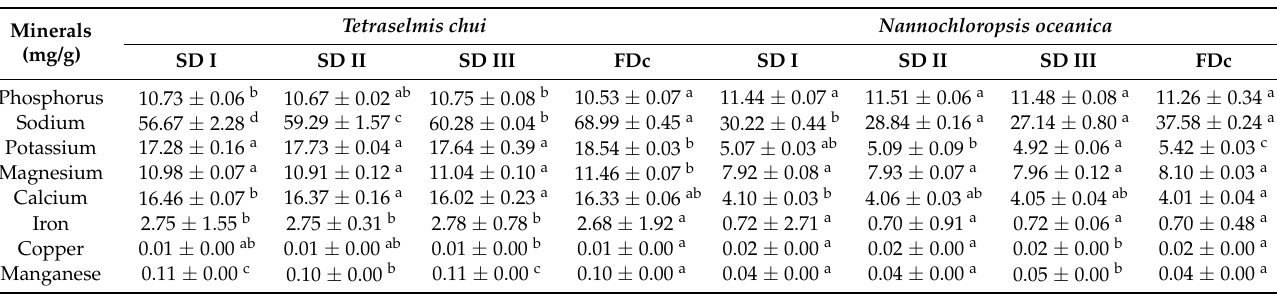
Table 4. Mineral contents of solar- (SD I, II, and III) and freeze-dried (FDc) Tetraselmis chui and Nannochloropsis oceanica biomass. Different letters represent significant differences among samples from the same species detected by Tukey’s post hoc range test (HSD, ANOVA). Data are shown as mean ± Std Dev ( n